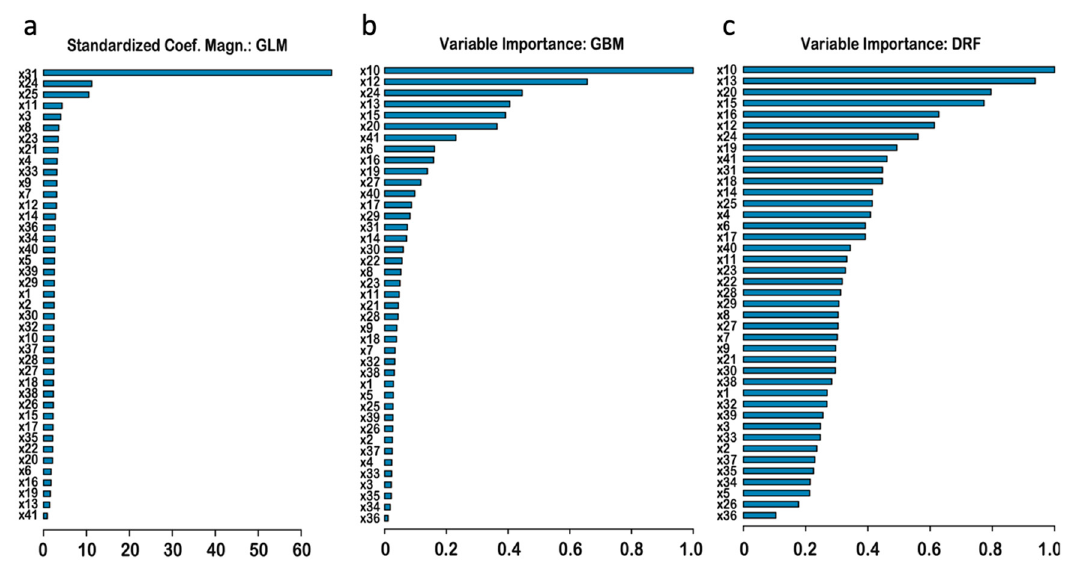
Figure 6. Ranking of the features by importance in the three base-learner models: GLM ( a ), GBM ( b ), and DRF ( c ), with importance decreasing from top to bottom.